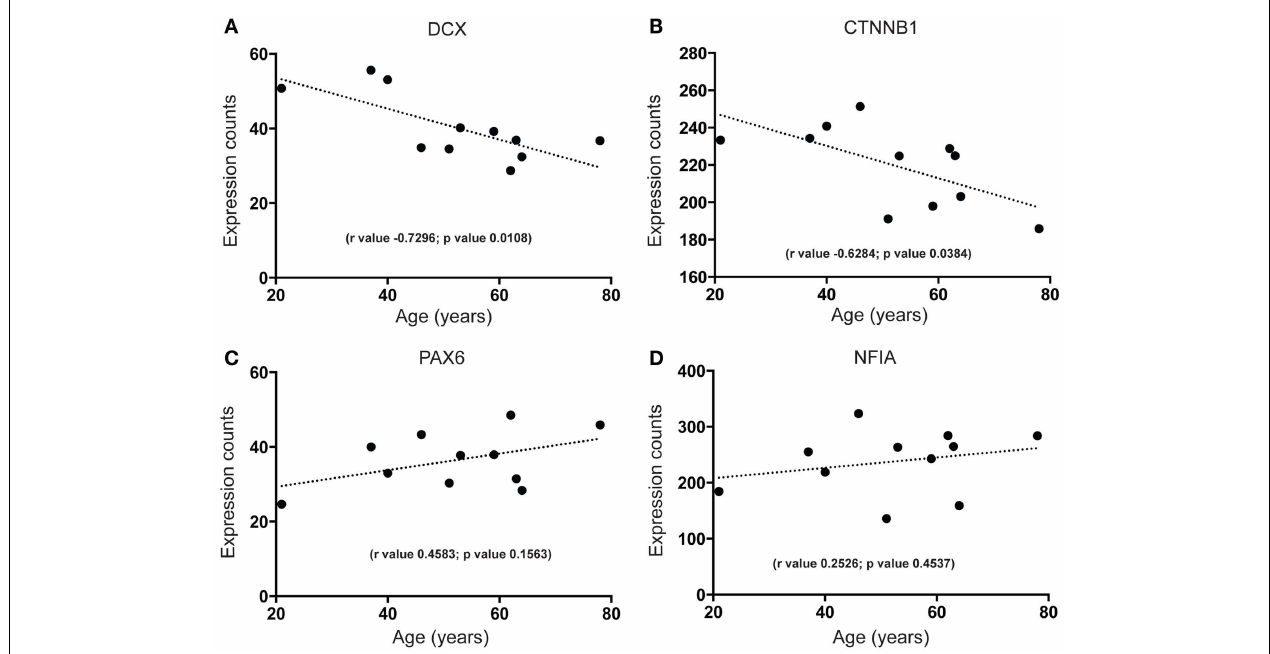
quantitative PCR; Figure S2A in Supplementary Material) and (B) a key promoter of neuronal proliferation β -catenin (CTNNB1). Non-significant age-dependent alterations are observed in the expression of radial glial markers (C) paired box 6 (PAX6) and (D) nuclear factor I A (NFIA). (Significance is defined as p value <